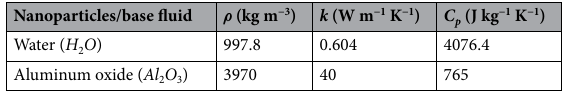
Nanoparticles/base